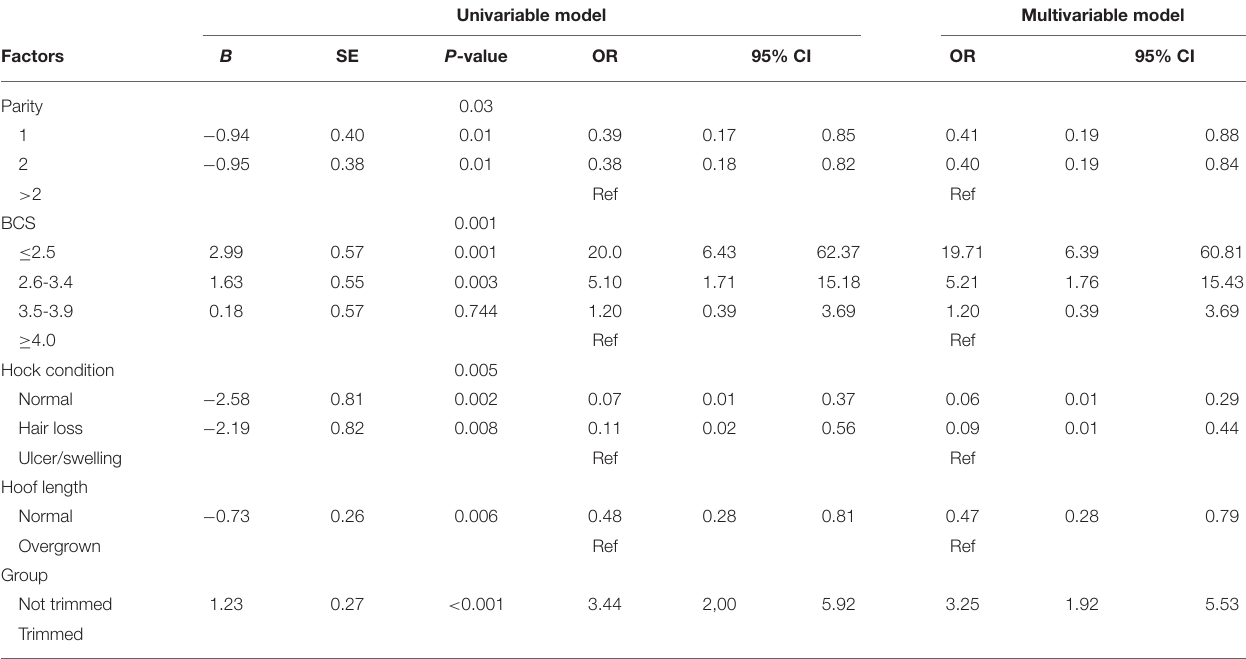
TABLE 6 | Univariable and multivariable logistic regression models showing the significant factors associated with non-infectious hoof lesions identified at the end of study